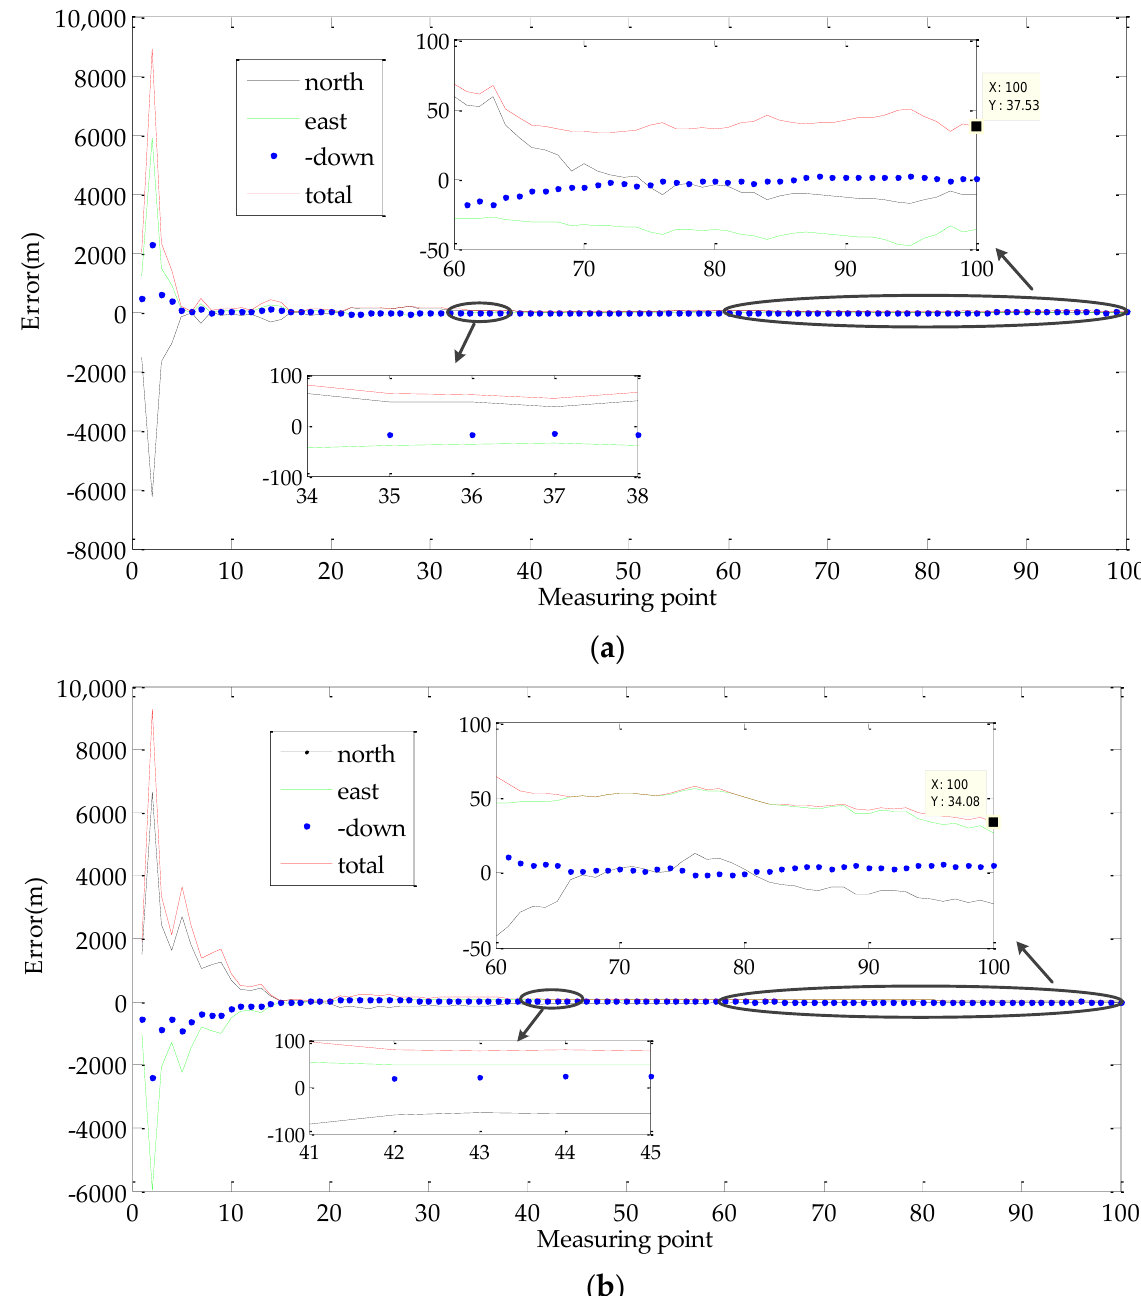
In order to verify the effectiveness of the proposed method, targets G1 and G2 were measured by the global navigation satellite system (GNSS) real time kinematic (RTK) method. The measuring equipment was survey-grade GNSS receivers I70 made by CHC- NAV. The positional accuracy for the points was less than 0.1 m and can be viewed as the standard value. The initial value of the target elevation was assumed equal to 800 m. The geo-location accuracy of the proposed method and the traditional method are shown in Figure 17 and Table 6.